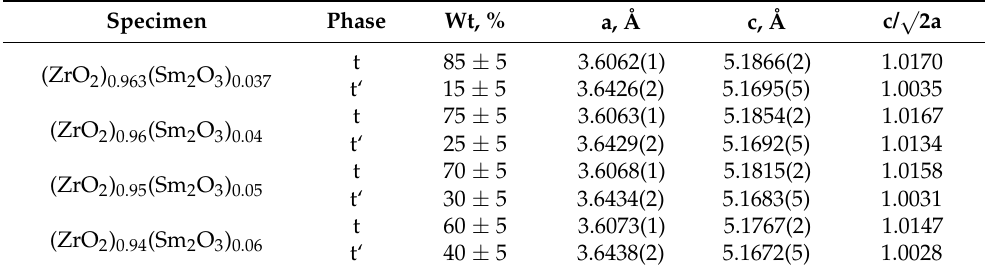
Table 1. Phase composition and lattice parameters in different tetragonal phases of (ZrO 2 ) 1-x (Sm 2 O 3 ) x crystals.